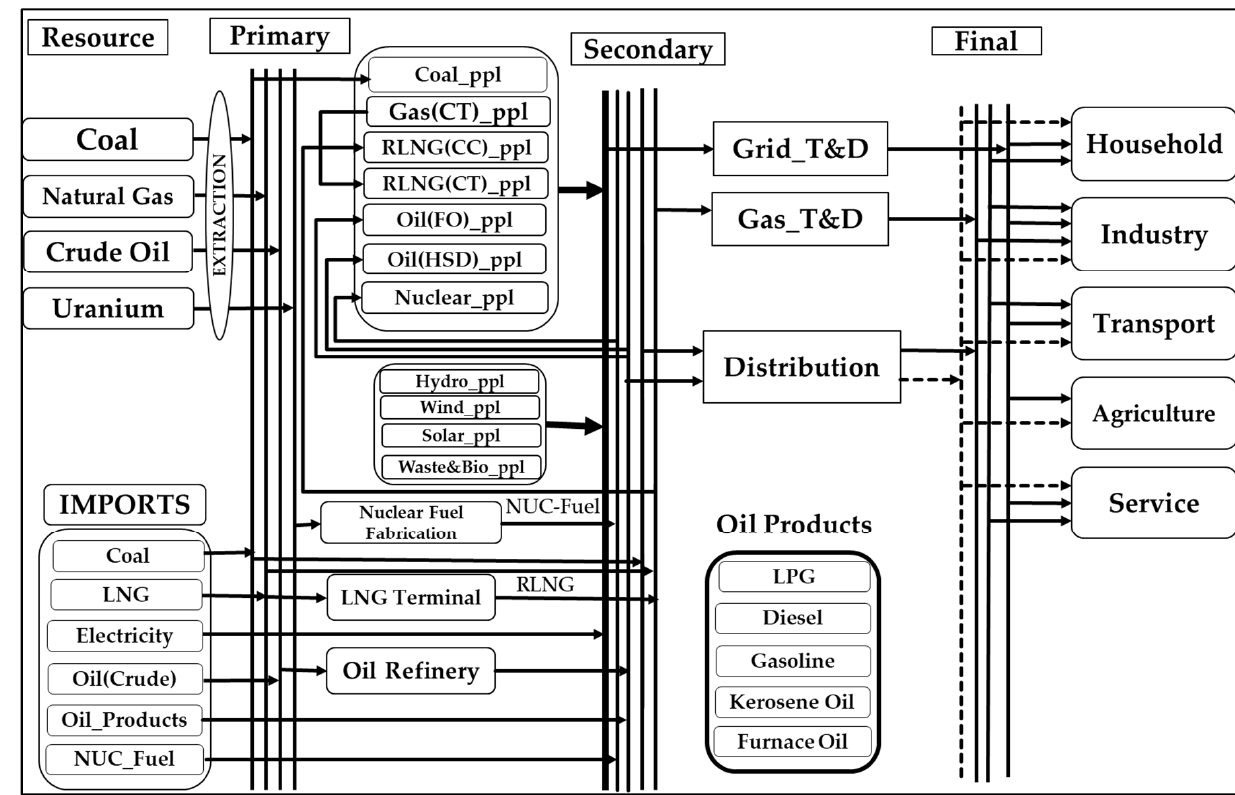
Figure 5. Framework of MESSAGE energy model .